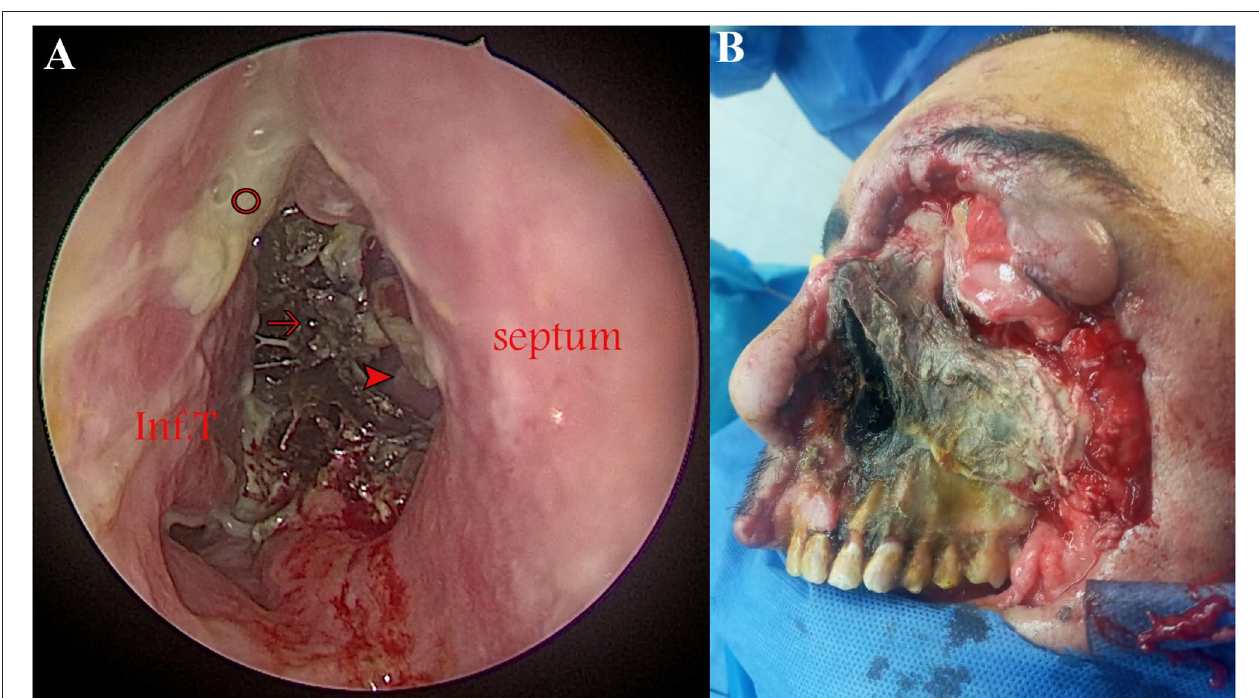
FIGURE 2 | Advanced rhino-orbital-cerebral mucormycosis (ROCM) in two patients. (A) Endoscopic view (0 ◦ lens) demonstrating black necrotic tissue filling the right nasal cavity (arrow), mucopurulent secretions (circle), and a perforation in the bony septum (arrowhead) through which the left inferior turbinate (Inf.T) can be seen. (B)